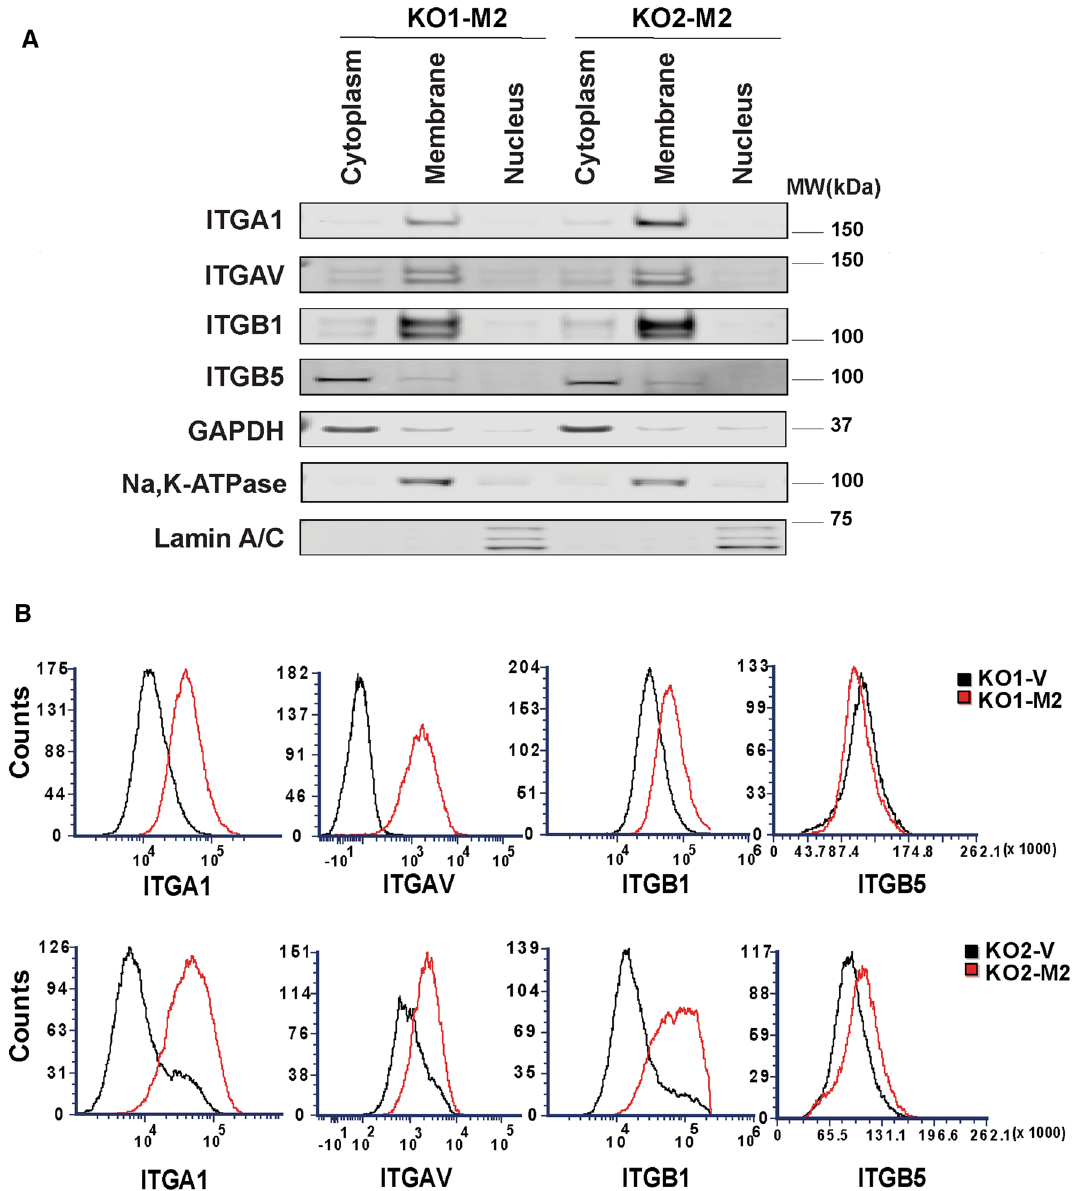
Figure 4. Subcellular Fractionation of α1, αv, β1, and β5 integrins in neuroblastoma cells highly expressing TRPM2. ( A ) Subcellular separation of two clones of SH-SY5Y KO cells reconstituted with TRPM2 (KO1-M2, KO2-M2) into cytoplasmic, membrane, and nuclear fractions was performed as described in "Materials and Methods". Western blotting was performed with fractionated samples loading equivalent amounts per lane (10 ug/lane). Blots were probed with antibodies to α1 (ITGA1), αv (ITGAV), β1 (ITGB1), β5 (ITGB5) integrins. Blots were also probed with antibodies to GAPDH (cytoplasmic marker), Na,K-ATPase α (plasma membrane marker which regulates Na and K ions and cell volume) and Lamin A/C (nuclear marker) as controls. Four experiments were performed with similar results and the results of one are shown. α1, αv, and β1 were predominantly found in the membrane fraction, and β5 in the cytoplasmic. Full length gels for these Western blots are shown in Supplementary Fig. S4. Membrane fractionations of Scr1-V, Scr2-V, KO1-V, KO2-V, KO1- M2, KO2-M2, KO1-E960D, KO2-E960D cells are also shown on Supplementary Fig. S4. ( B ) Flow Cytometry of α1, αv, β1, and β5 integrin expression on the surface of non-permabilized SH-SY5Y KO cells (KO1-V, KO2-V) and KO cells expressing TRPM2 (KO1-M2, KO2-M2). Fluorescent intensities (X-axis) of integrins α1, αv, and β1 were increased on the surface of KO-M2 compared to KO-V cells. This experiment was performed twice with similar results and results of one experiment are